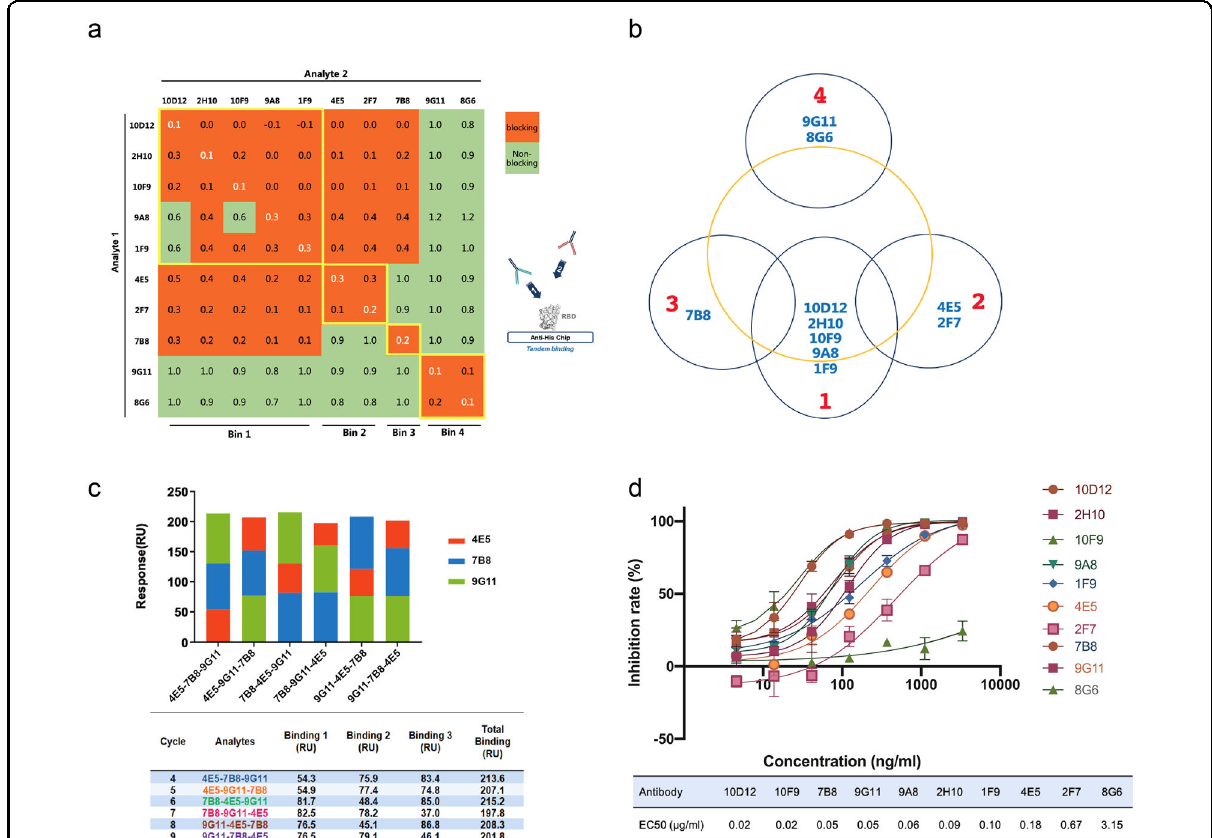
Fig. 1 Separable binding interfaces of a group of hACE2-blocking antibodies derived from RenMab mice. a The relative positions of epitopes on the SARS-CoV-2 RBD domain where ten blocking antibodies could bind were examined by a sequential fl ow of any two antibodies (in all combinations) over the biosensor surface-immobilized with SARS-CoV2 RBD and evaluated by an index, which was calculated as the ratio of RU (analyte 2 in the absence of analyte 1) to RU (analyte 2 in the presence of the indicated analyte 1). Boxes with a score of 0.6 or greater were colored green, and those with a score smaller than 0.6 were colored orange. The clones that belong to the same bin were indicated by the area enclosed by yellow lines. b Schematic diagram of the relative positions of four distinct bins of antibodies. The yellow circle represents the hACE2-binding interface on SARS-CoV-2 RBD. c Simultaneous binding by three nonoverlapping antibodies. SARS-CoV2-RBD was immobilized on a biosensor as bait. 4E5, 7B8, and 9G11 fl owed into the system sequentially in the indicated order. d hACE2-blocking antibodies ef fi ciently neutralize the pseudotyped virus in cell culture. Five representative antibodies derived from RenMab mice were fi rst incubated with SARS-CoV-2 (WH01) pseudotyped virus at the titrated concentration, then the mixtures were applied to Huh-7 cells. The neutralizing activity was visualized by plotting the luciferase signal after 24 h against the antibody